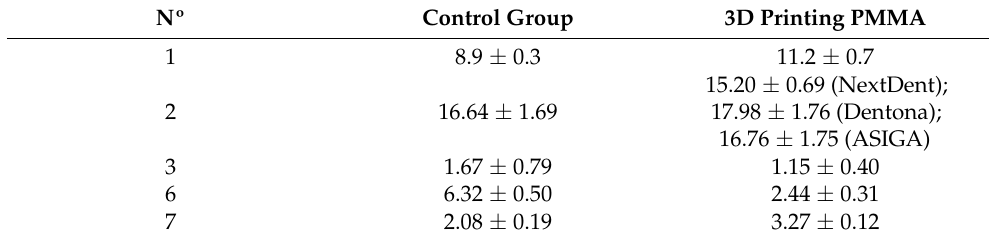
Table 5. Average values of impact strength 1